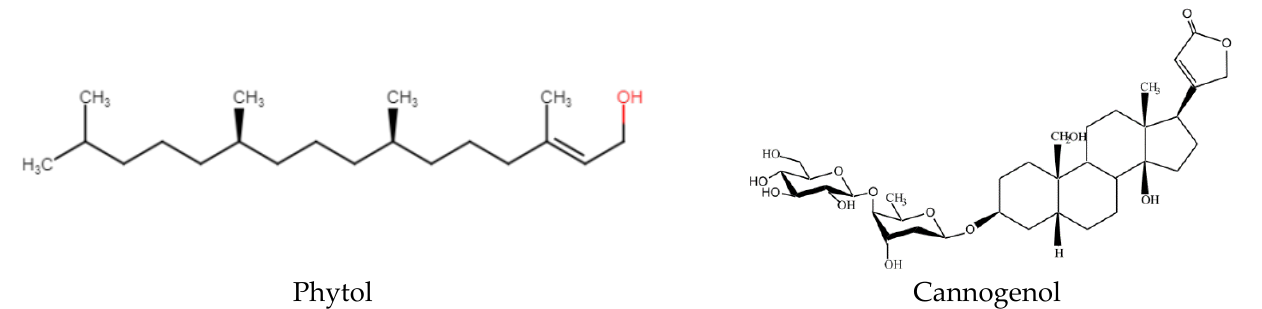
Phytol Cannogenol Figure 3. Chemical structures of the most common bioactive compound available in C. capsularis and C. olitorius . Table 3. Chemicals isolated from different parts of C. capsularis and C. olitorius.